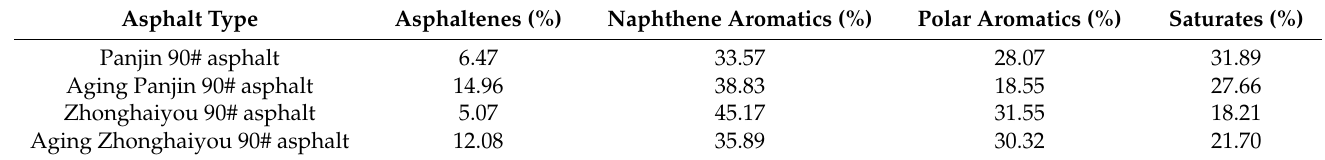
Table 1. Composition of all asphalt